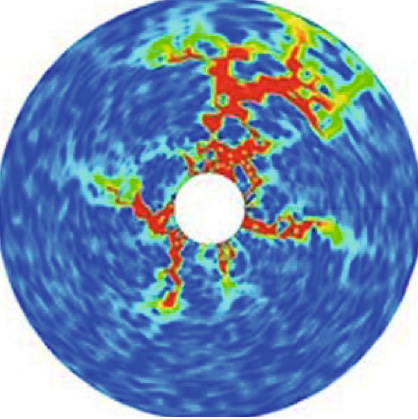
Figure 1: Wormholes generated by acid fl uid dissolution [6].